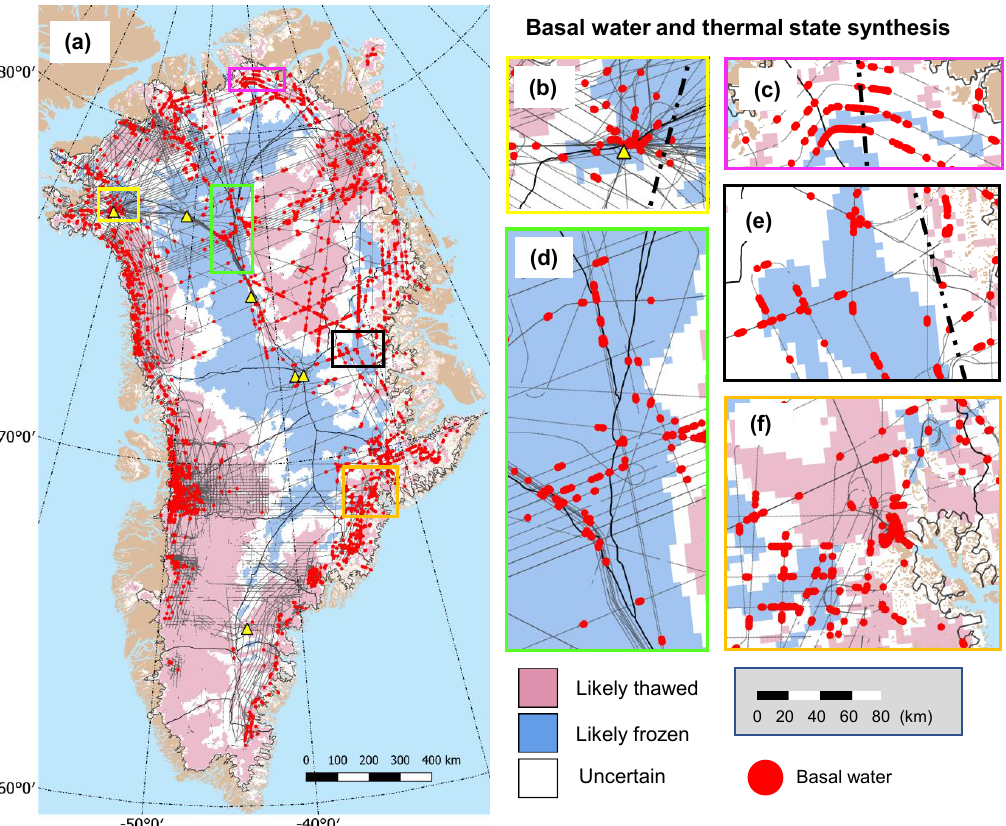
Figure 7. Comparison between basal water distribution and basal thermal state synthesis by MacGregor et al. (2016). (a) Ice-sheet scale. Major regions of disagreement (water in likely frozen regions) are highlighted in the zoomed-in panels. (b) Camp Century. (c) Far north. (d) North-central ice sheet. (e) East of GRIP. (f) Around Kangerlussuaq. The zoomed-in panels all have the same scale ( × 5 the resolution of a